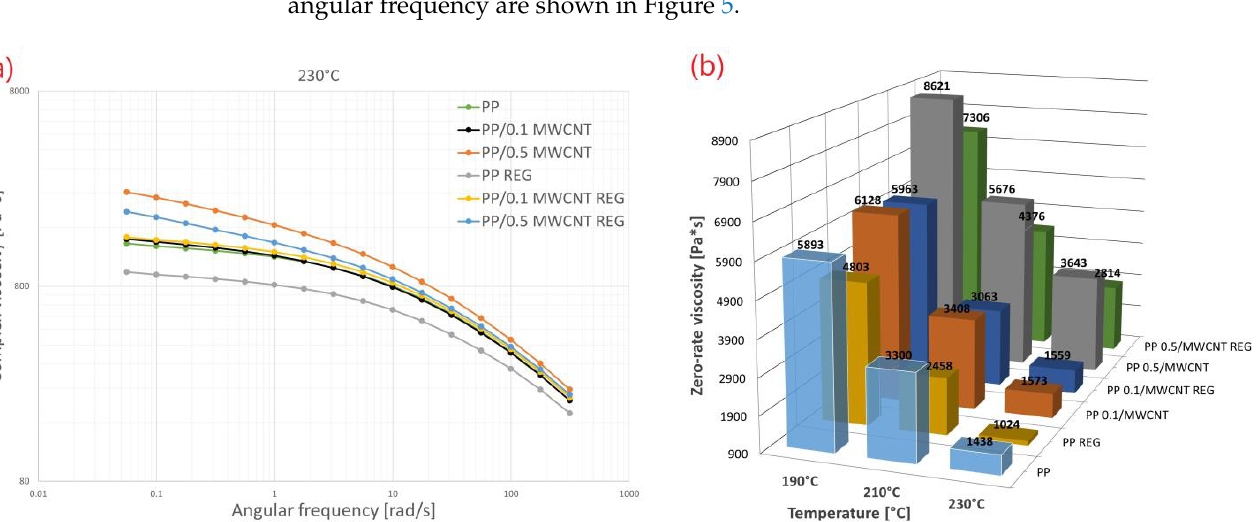
Figure 4. Measured curves (( a ) storage and ( b ) loss modulus) of the PP/MWCNT by oscillation at 230 °C.